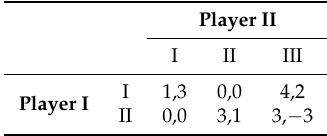
Table 10. A variant of Battle-of-Sexes